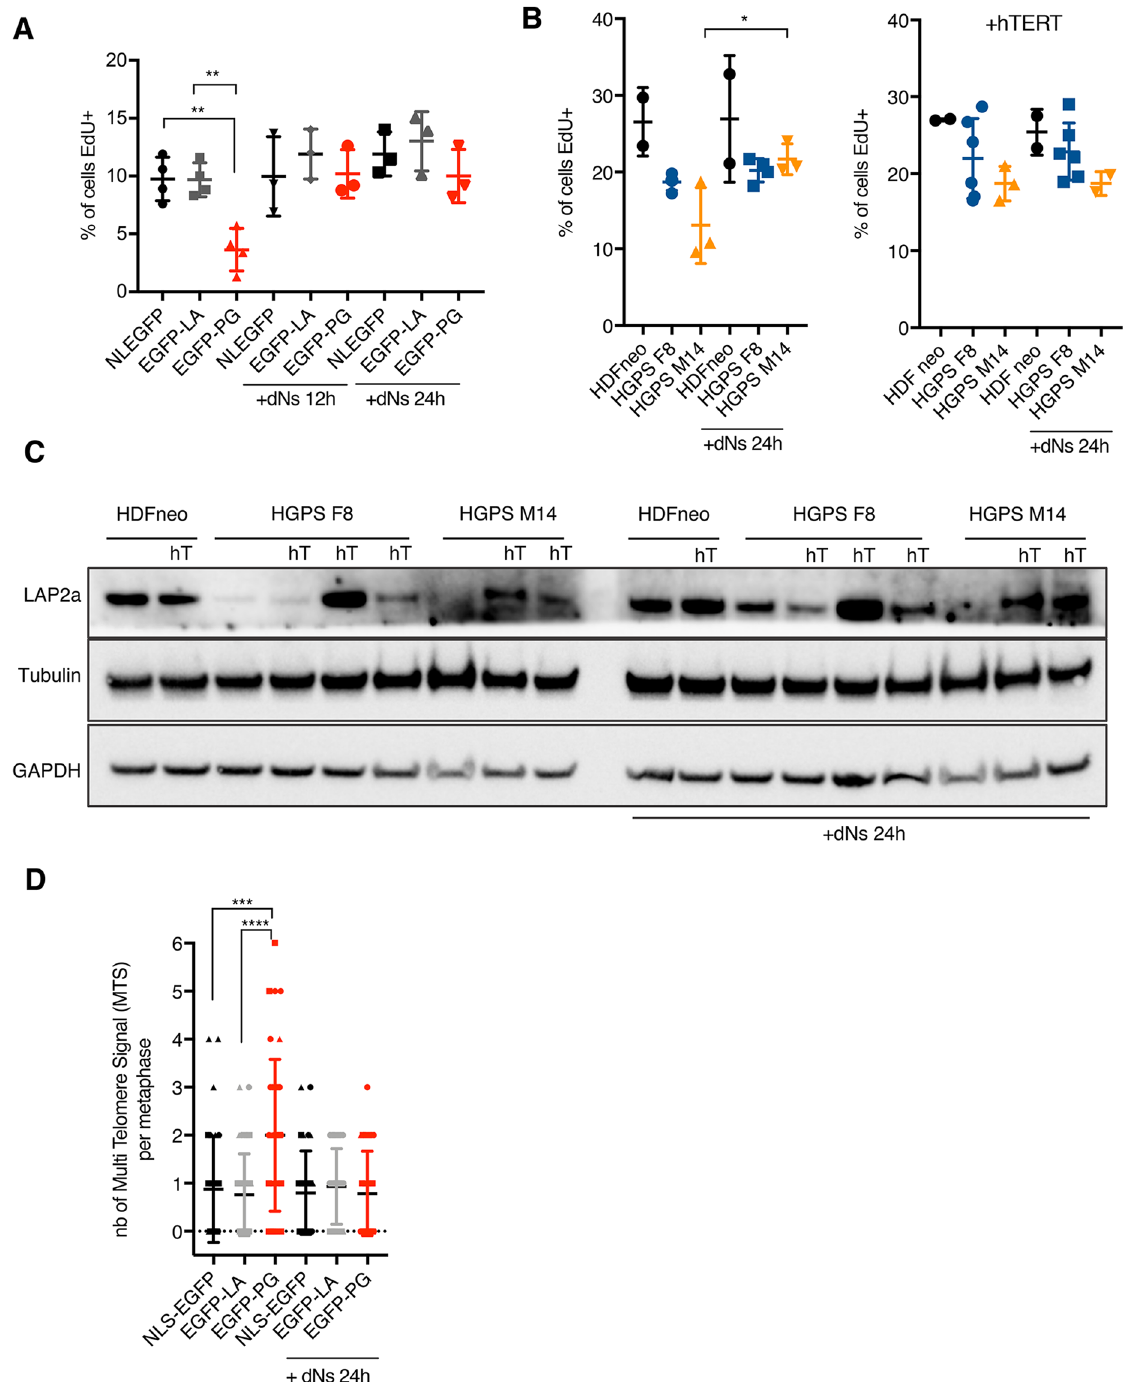
Figure 6. Progerin expression limits dNTPs accessibility. ( A ) Percentage of EdU positive cells in HDFs expressing NLS-EGFP (N), EGFP-LA (A), and EGFP-PG (P). When indicated, cells were supplemented with dNTPs for 12 or 24 h, then pulse-labeled with EdU for 30 min. Mean with SD is shown, n = 3. Statistical significance was determined using one-way Anova (**indicates p < 0.001). ( B ) Percentage of EdU positive cells in HDF and HGPS cells with (right) or without (left) hTERT expression. When indicated, cells were supplemented with dNTPs for 24 h, then pulse-labeled with EdU for 30 min. Mean with SD is shown, each dot corresponding to a replicate (n = 2 to n = 6 depending of the cell line). Statistical significance was determined using one-way Anova (*indicates p < 0.005). ( C ) Western blot of total extracts extracted from the indicated cell lines. When indicated, cells were supplemented with dNTPs for 24 h before collecting. ( D ) Quantification of MTS in HDF expressing the indicated constructs. The graphs represent the number of MTS per metaphase. Mean with SD is shown, n = 3. At least 30 metaphases were scored per condition in total. Statistical significance was determined using Mann Whitney test (***indicates p < 0.0005, and ****p <